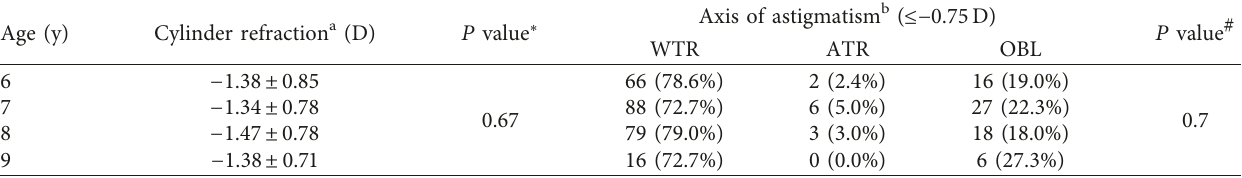
Table 1: Cylinder refraction and axis of CSA children in different age groups.